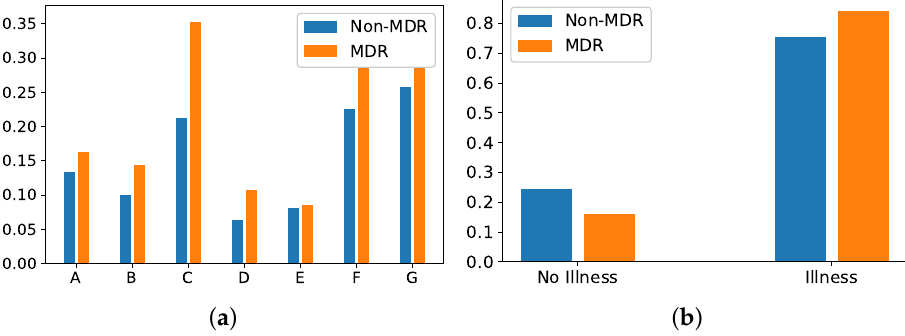
Figure 7. Rate of MDR and non-MDR patient episodes associated with: ( a ) each group of diseases; ( b ) illness